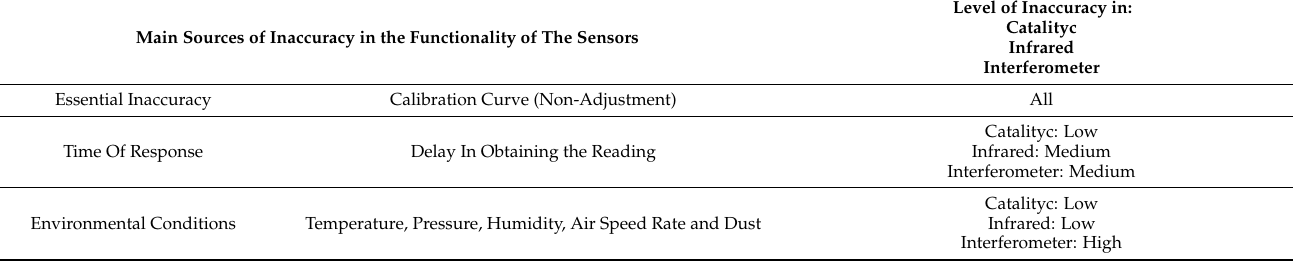
Table 8. Main sources of inaccuracy